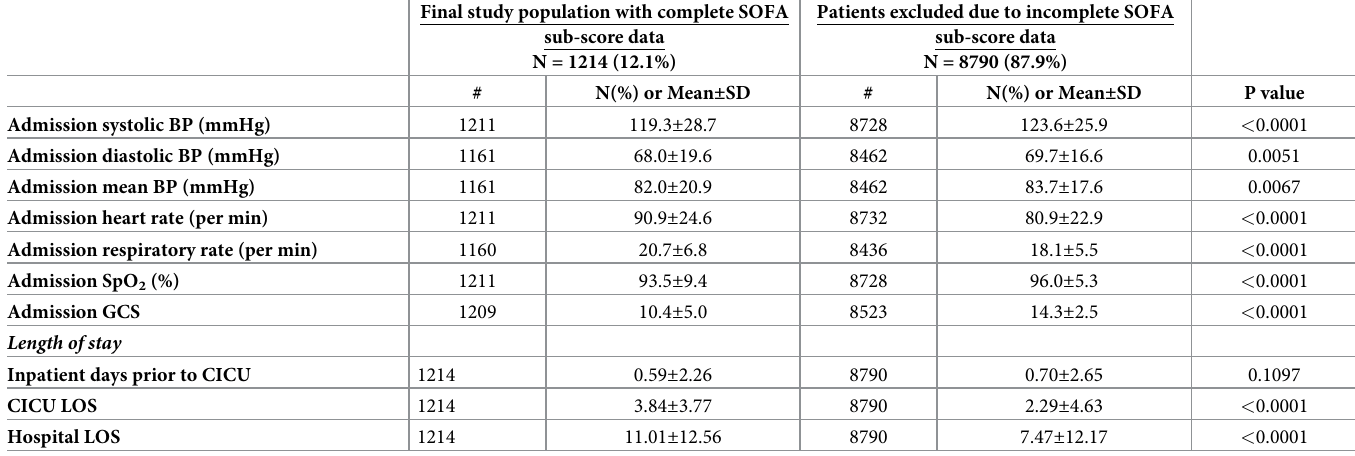
population (S2 Fig). The mean SOFA score of 8 in the final study population corresponds to the 90 th percentile for the initial population.[15] In the final study population, all-cause CICU mortality occurred in 208 (17.1%) patients, hospital mortality occurred in 311 (25.6%) patients, and 30-day mortality occurred in 356 (29.3%) patients; these mortality rates are higher than previously reported for the initial study population.[15] Short-term mortality was significantly (p < 0.001) higher in the final study population compared to excluded patients with missing SOFA sub-score data (S3 Fig), as were CICU and hospital length of stay (Table 1). Notably, there was a U-shaped relationship between number of SOFA sub-scores with available data and short-term mortality (S4 Fig).